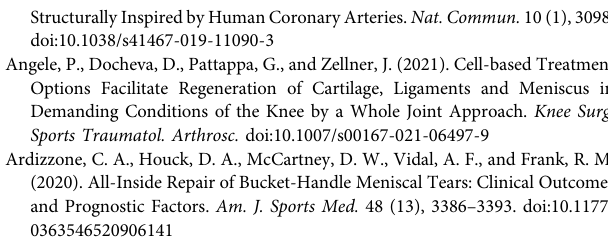
Supplementary Figure S2 | Cell viability of IPFP-MSC seeded pneumatospun collagen scaffolds after overnight incubation on orbital shaker. (A) Live cells (green) and (B) dead cells (red) (Magni fi cation 10x). Supplementary Figure S3 | ImageJ was used for image processing to remove background staining and extract green (live/cytoplasm) and dead (red /nuclei) cells for viability assessments. (A) Confocal microscopy image; (B) Live cells labeled green (cell count = 13,773); (C) Dead cells labeled red (cell count = 1201): cell viability = 92% (bar = 1000 µm). Supplementary Figure S4 | Immunohistochemistry for collagen types I and II. Left column: Negative isotype controls; Right column: positive stains. (A,B) Type I collagen stain for bovine meniscus; (C,D) Type I collagen stain for human meniscus; (E,F) Type II collagen stain for human articular